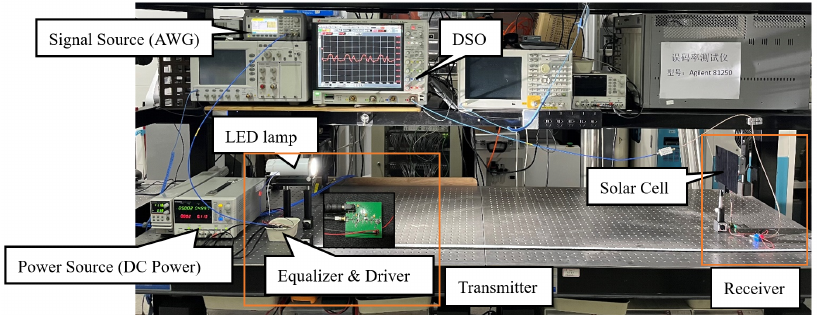
Figure 5. Performance test of prototype